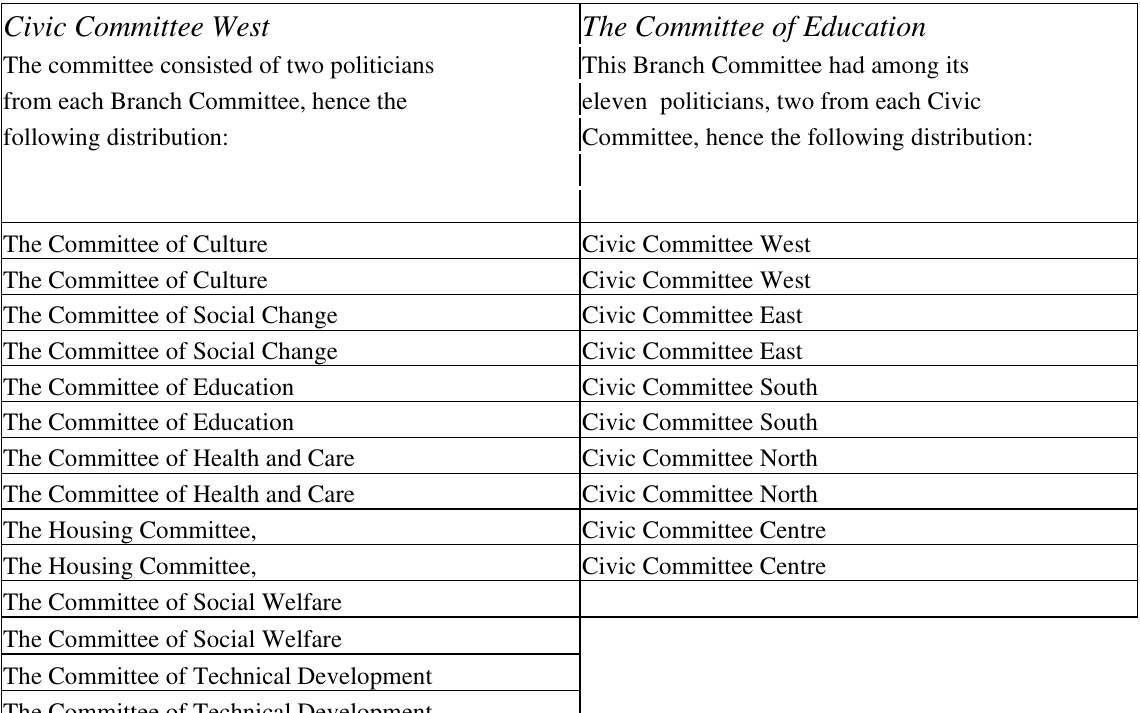
Figure 2: The Intersectorial and comprehensive design of the committees in the Municipality of